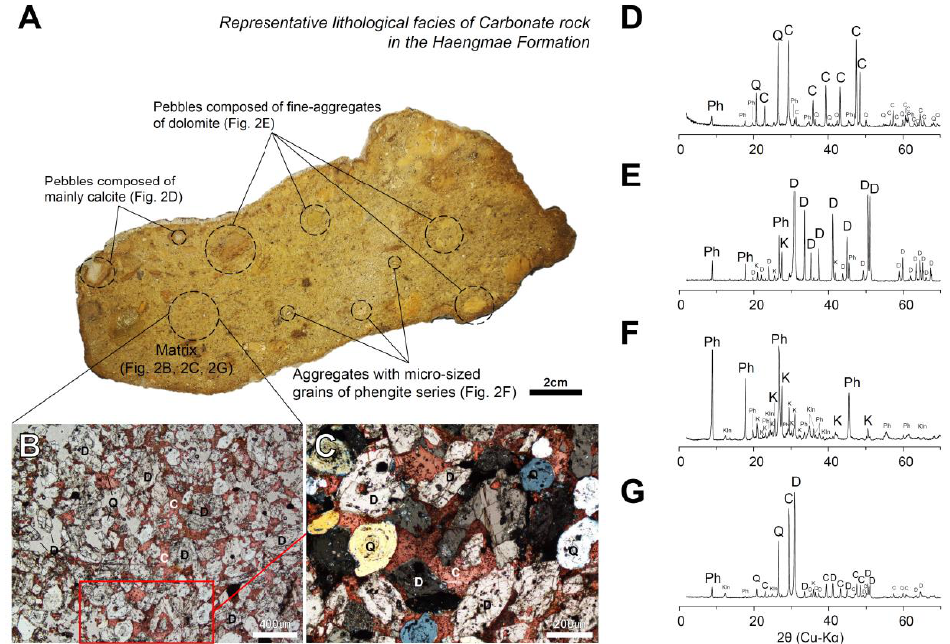
Figure 2. ( A ) Representative lithological facies of carbonate rock in the Haengmae Formation. Polished slab of the typical Haengmae Formation is characterized by the yellowish-brown in color and the various types of pebble, containing a large aggregate with microsized dolomite, calcite-dominant rock, phyllitic rock and a white-colored aggregate of phengite; ( B ) polarized microscopic images of the matrix under plane polarized light (PPL) mode after alizarin red S staining, showing a typical texture composed of single crystalline dolomite, well-rounded and well-sorted quartz grains with calcite fillings, and ( C ) its enlarged image under crossed polarized light (XPL) modes. X-ray di ff raction results of ( D ) the pebbles of calcite-dominant rock, ( E ) a large aggregate with microsized dolomite, ( F ) a white-colored aggregate of phengite, and ( G ) the typical matrix. Abbreviations: